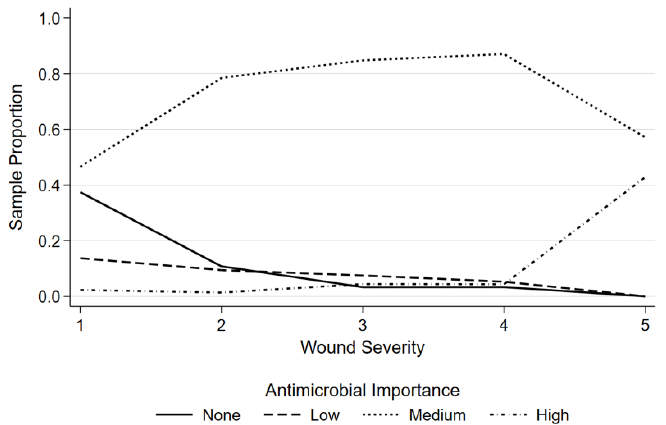
Figure 4. Antimicrobial importance class prescribed versus wound severity grade for 1713 dog-to-dog bite events presenting for treatment between 1998 to 2018.